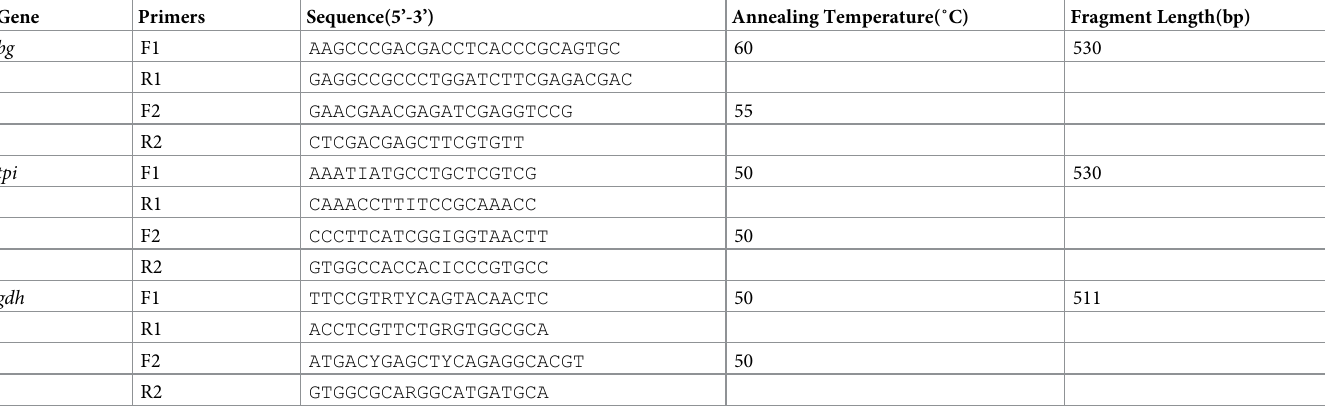
Table 1. Primer sequences, annealing temperatures and the fragment lengths of the genes used in this study. Gene